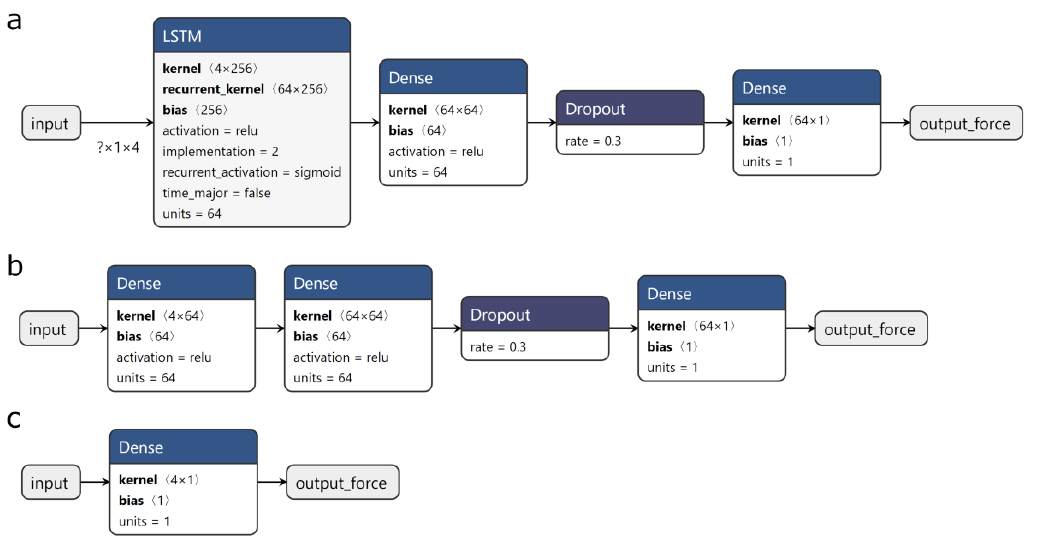
Figure A5. Thermal conductivity test specimens and setup: ( a ) specimens enclosed in identically sealed polyethylene bags to prevent affecting the results by ethanol evaporation (left— silicone/ethanol material-actuator specimen, right—silicone/ethanol with thermally-conductive filler), ( b ) specimen in the guarded hot plate device (design described in [38]).